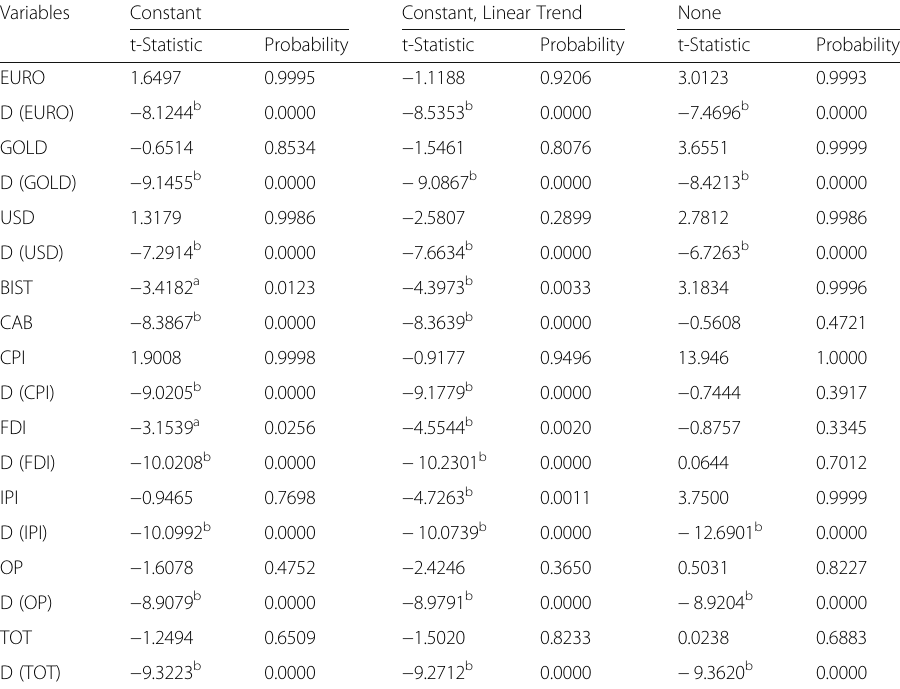
Table 1 ADF unit root test